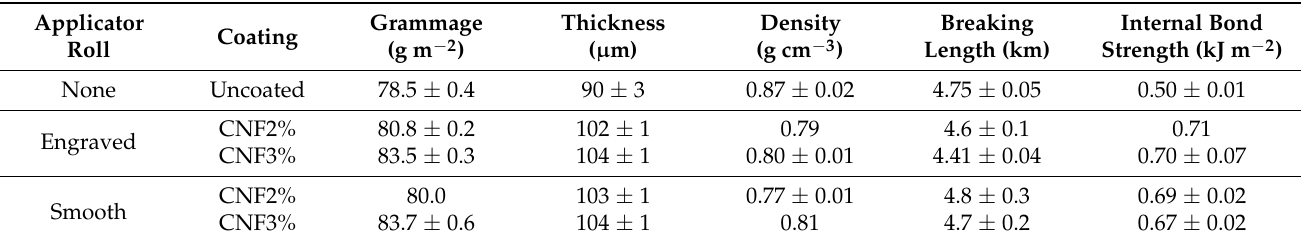
Table 2. Weight, dimensional, and mechanical properties of the sheets coated only with aqueous suspensions of cellulose nanofibers. The amplitude of the intervals equals twice the standard deviation.